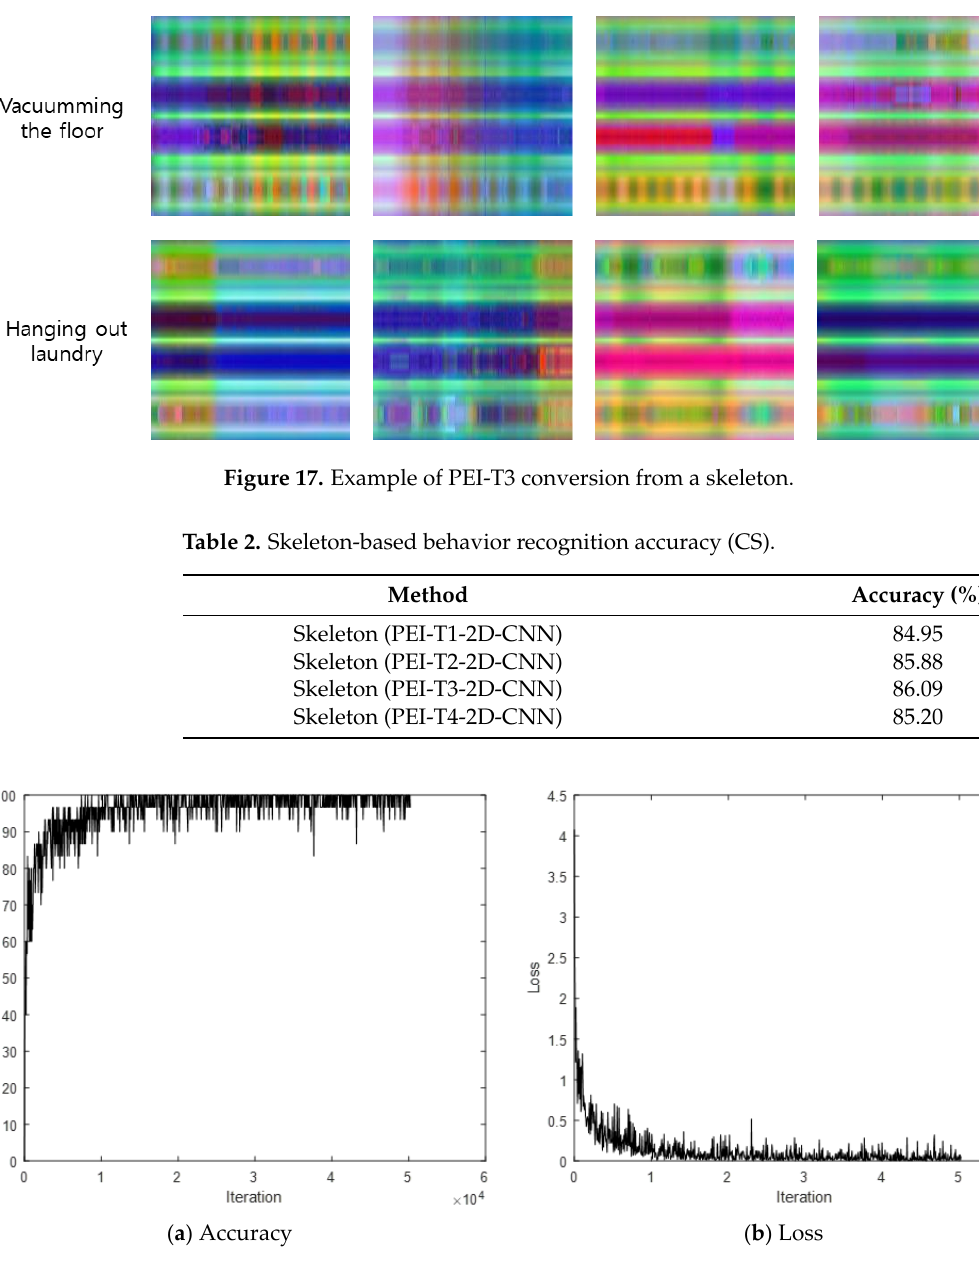
Figure 18. Graph depicting learning process of